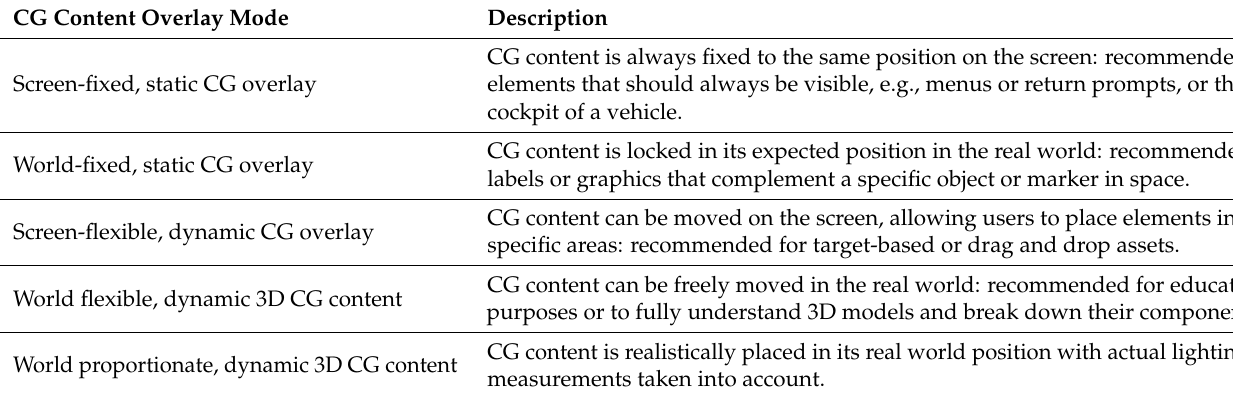
Table 7. Static and dynamic methods to overlay CGI to the physical